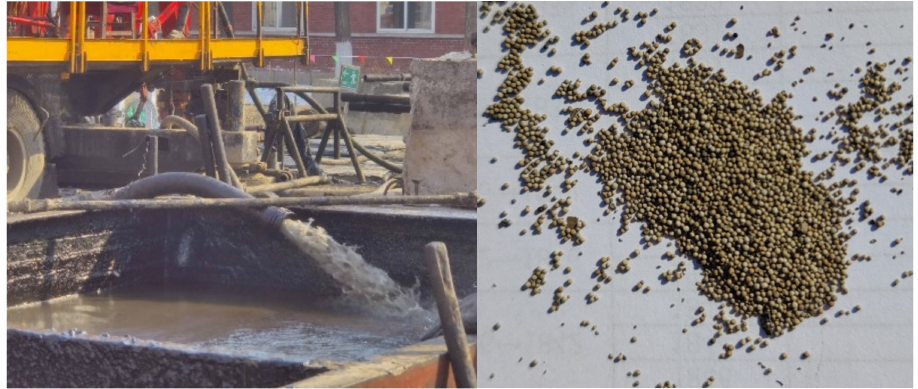
Figure 23. Returning fluid and sand output during the flushing